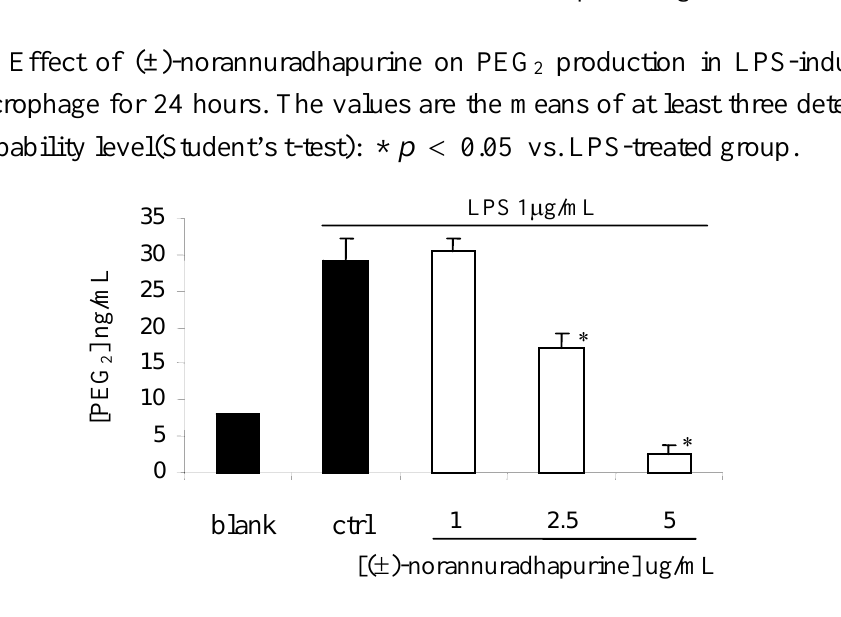
Figure 3 . Effect of (±)-norannuradhapurine on iNOS protein production by LPS-induced RAW 264.7 macrophage for 24